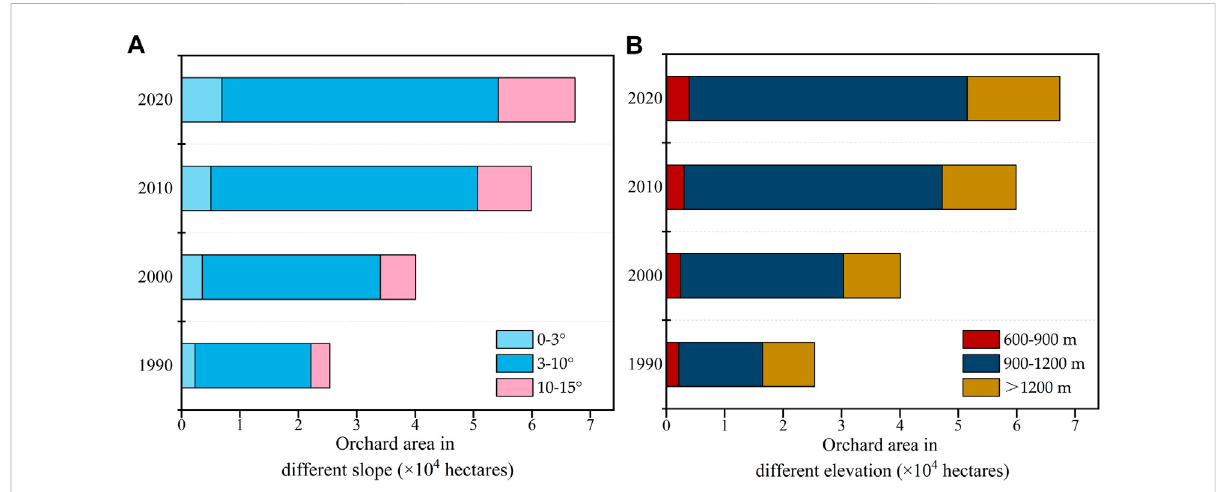
FIGURE 8 Variation in orchard expansion with elevation and slope. (A,B) Shows the orchard area under different slope and elevation,